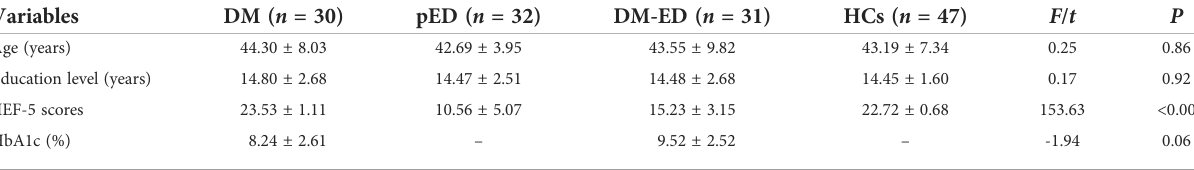
TABLE 1 Demographic and clinical characteristics.